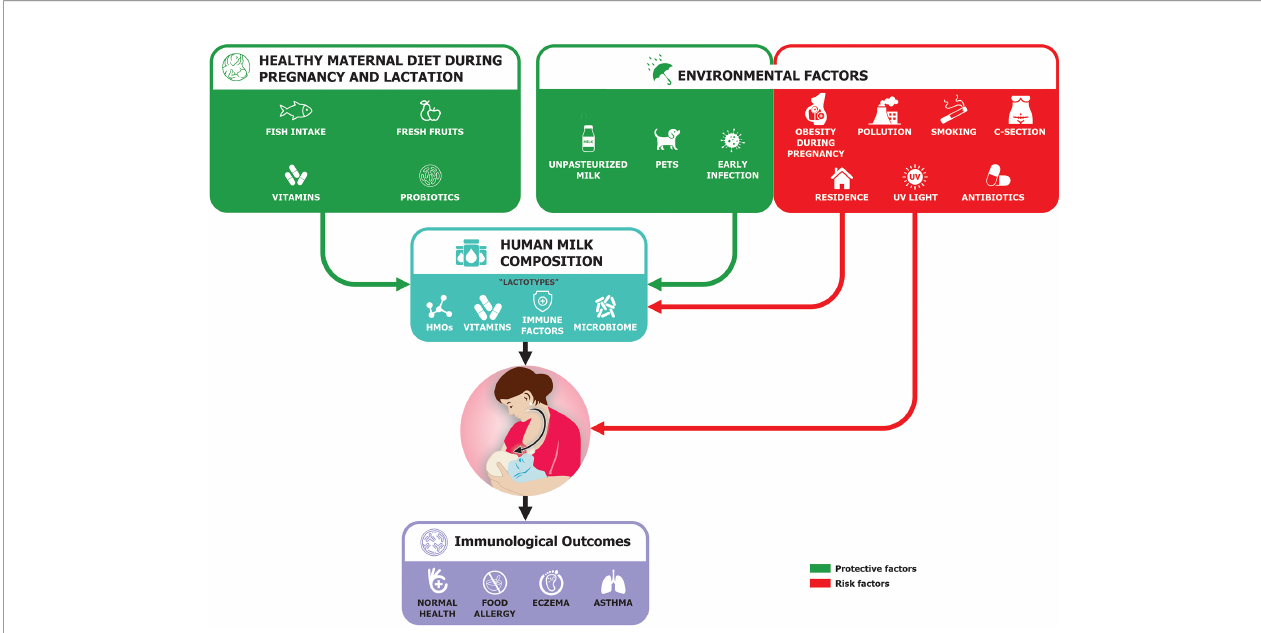
FIGURE 2 | Possible maternal in fl uence on immunological outcomes in child [adapted from Verhasselt (40) and Munblit et al.